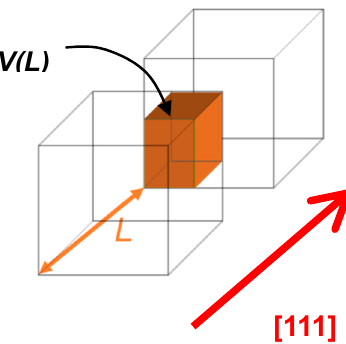
Figure A4. Graphical depiction of the common volume function along direction [111] for a cube.